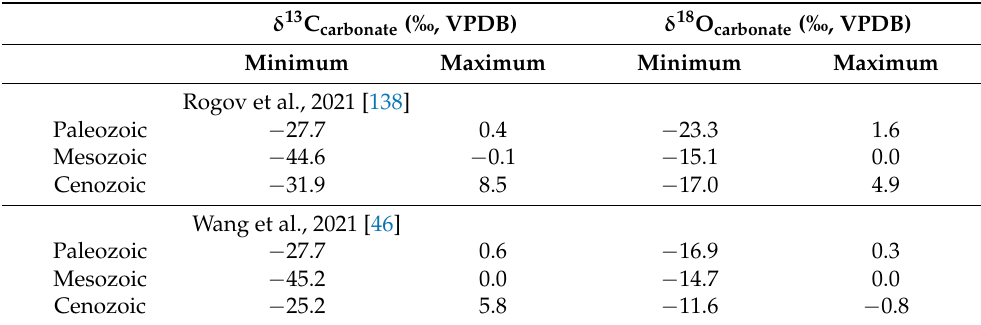
Table 4. Maximum and minimum carbon and oxygen isotope ratio values of glendonites in databases from Rogov et al. [138] and Wang et al.